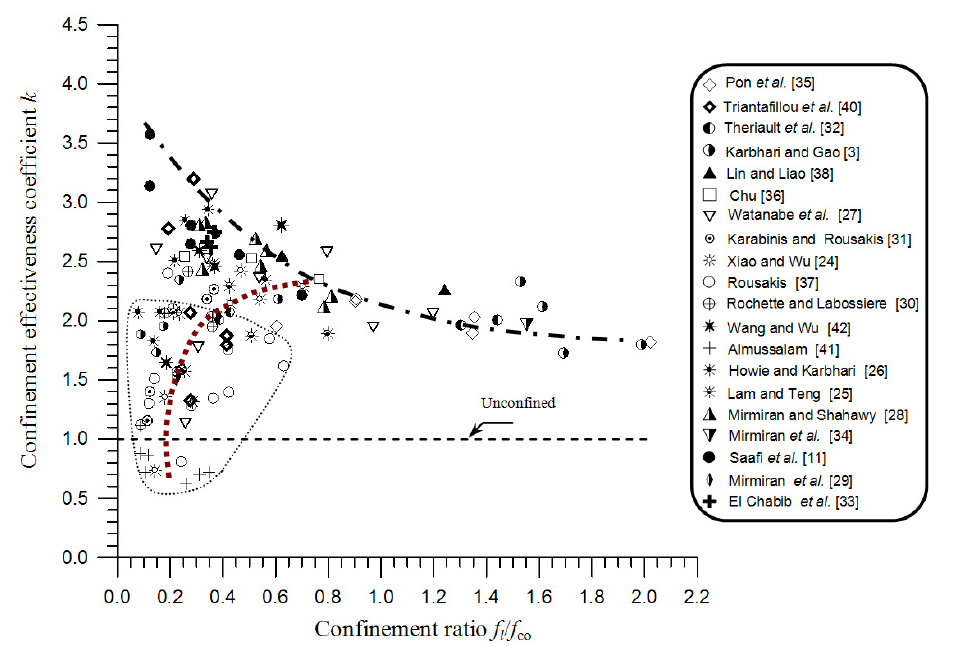
Figure 3. The variation of confinement efficiency in FRP-wrapped and FRP-encased